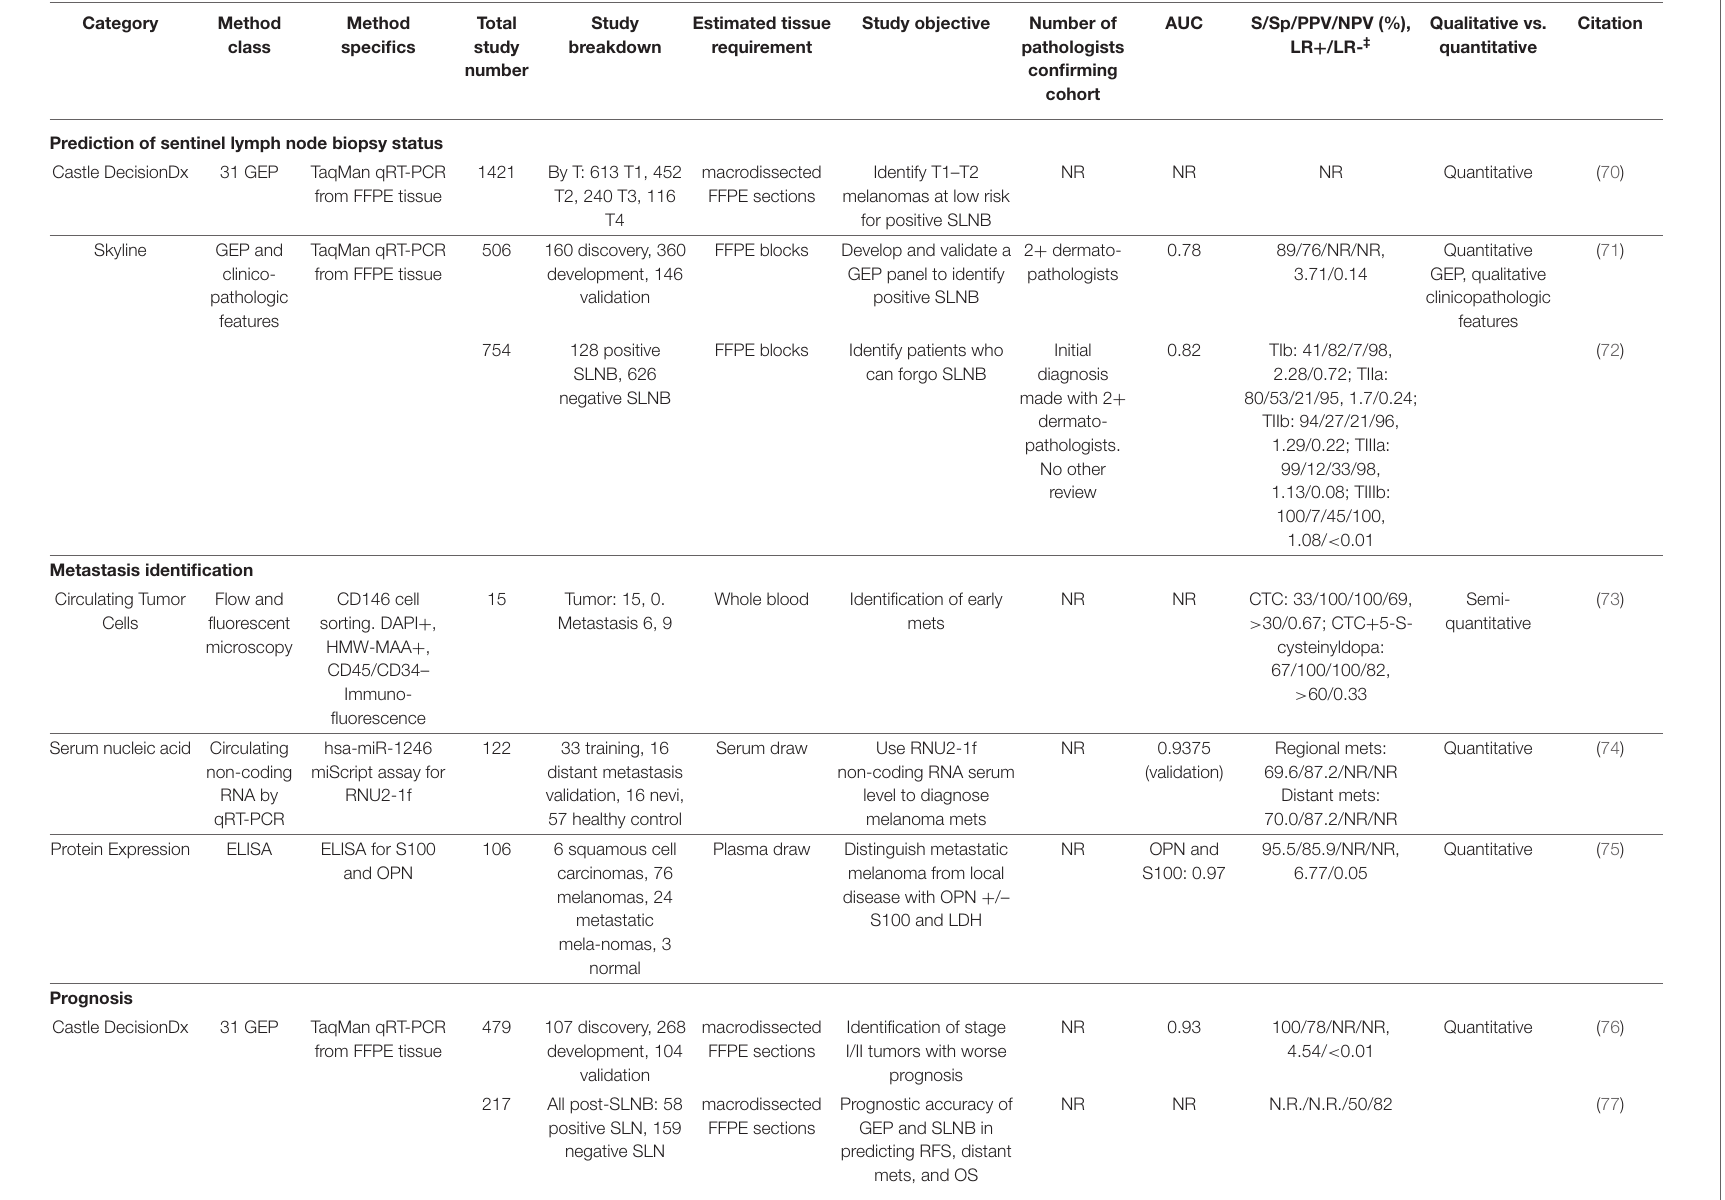
TABLE 4 | Proposed prognostic, staging, and treatment-monitoring